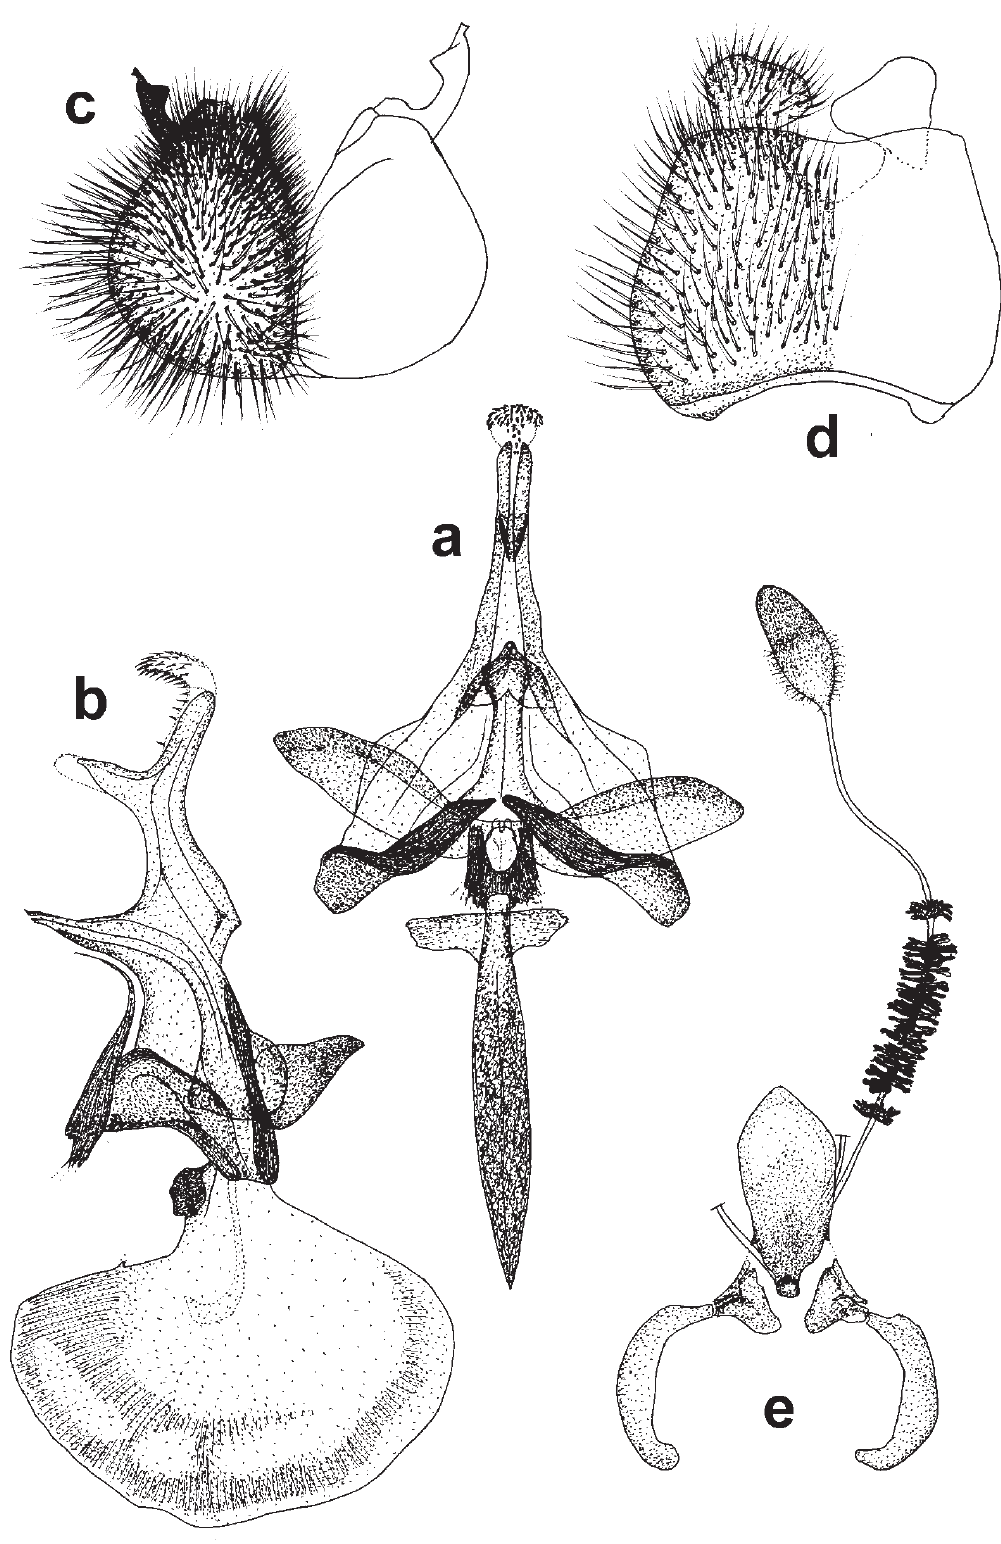
Fig. 60. Parusia almeria sp. nov. a . Epiphallic complex ventral. b . Epiphallic complex lateral. c . Gonocoxite ventral. d . Epandrium dorsal. e . Female genitalia